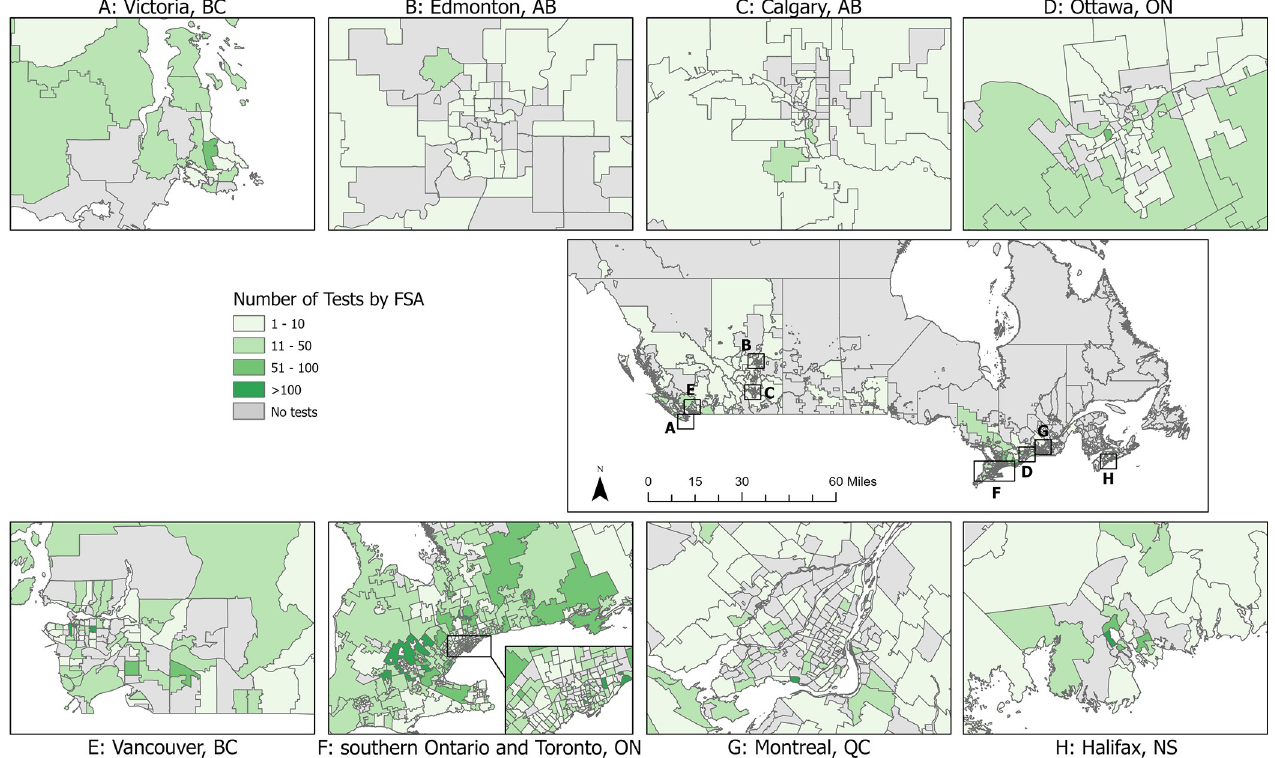
Fig 1. Number of submitted canine Leptospira PCR tests by forward sorting area (FSA) in Canada, 2009–2018. FSA for submitting veterinary